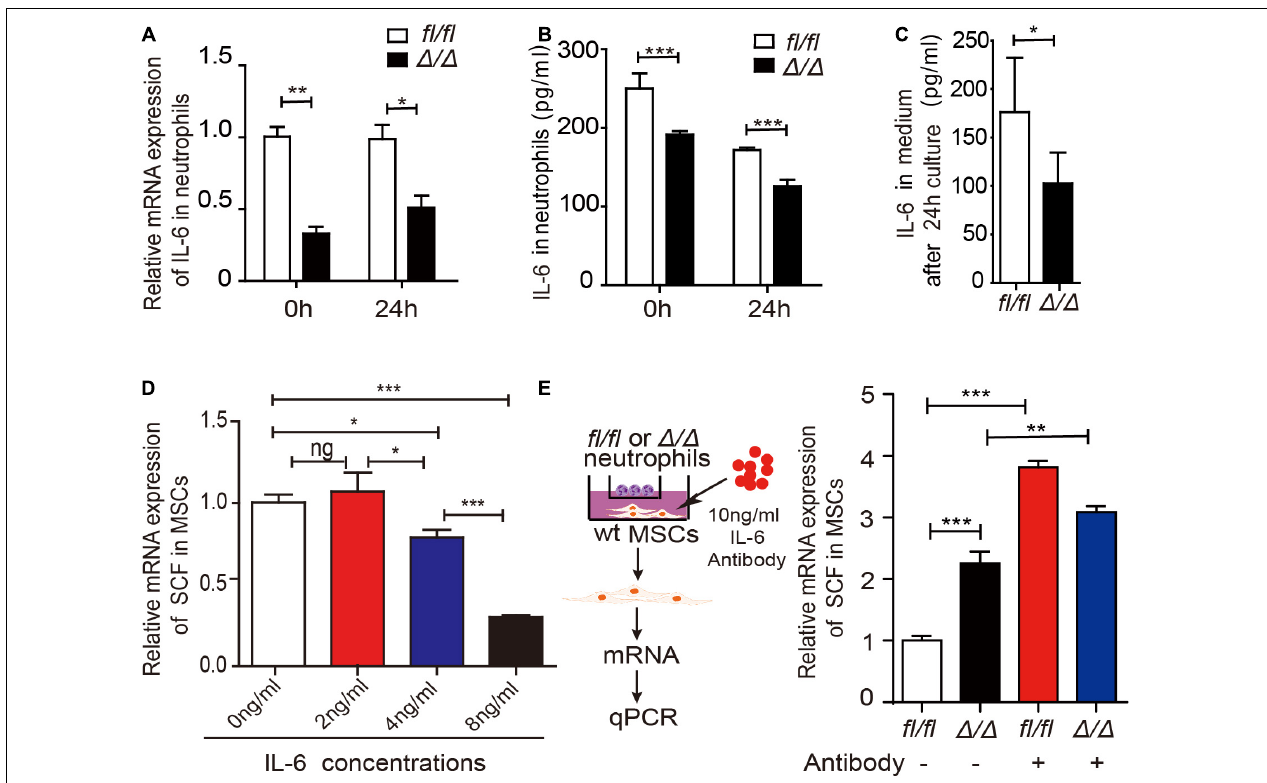
FIGURE 5 | Rheb1 -deficient neutrophils stimulate MSCs to produce more SCF by decreasing IL-6 expression. (A) The relative mRNA expression of IL-6 in Rheb1 fl / fl or Rheb1 (cid:49)/(cid:49) neutrophils when separated from BM (0 h) or after 24 h of coculture with MSCs ( n = 3). (B) The protein levels of IL-6 in the cell lysates of Rheb1 fl / fl and Rheb1 (cid:49)/(cid:49) neutrophils when separated from BM (0 h) or after 24 h of coculture with MSCs ( n = 3). (C) The IL-6 levels in the media of Rheb1 fl / fl or Rheb1 (cid:49)/(cid:49) neutrophils cocultured with MSCs ( n = 4). (D) The relative mRNA expression of SCF in wt MSCs after exposure to different concentrations IL-6 for 24 h ( n = 3). (E) The relative mRNA expression of SCF in wt MSCs cocultured with Rheb1 fl / fl or Rheb1 (cid:49)/(cid:49) neutrophils after being exposed to an IL-6 antibody at 10 ng/ml for 24 h ( n = 3). * P < 0 . 05; ** P < 0 . 01; *** P < 0 . 001.